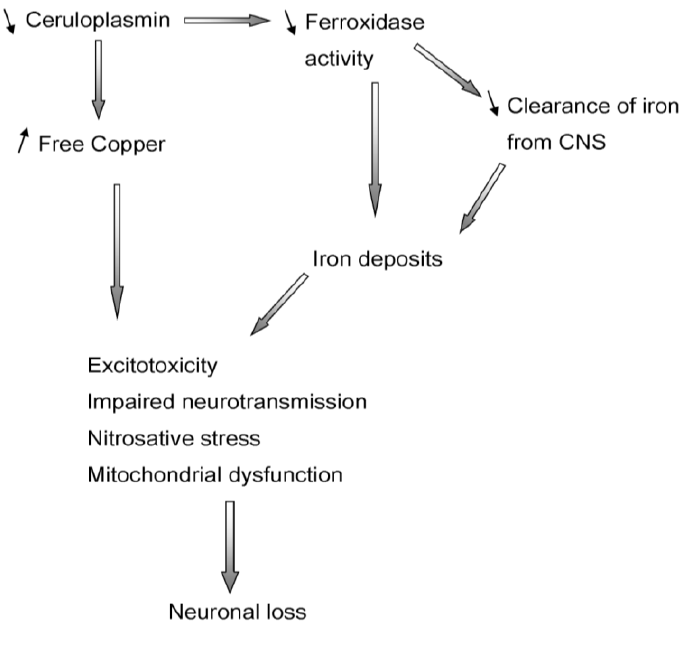
Figure 4. Cascade of the events triggered by decreased levels of ceruloplasmin. Levels of free copper rise and iron deposits occur, leading to excitotoxicity, enhanced nitrosative/oxidative stress and damage to